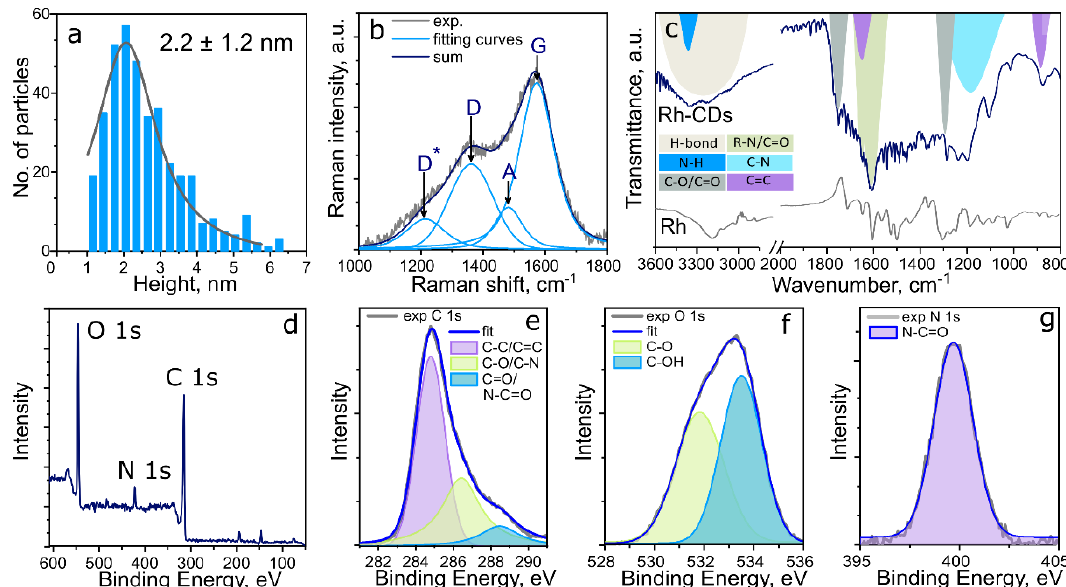
Figure 1. ( a ) Atomic force microscopy (AFM) height distribution of Rhodamine (Rh)-CDs. ( b ) Raman spectrum of Rh-CDs (exp., grey) and its deconvolution (sum, dark blue) into four peaks (fitting curves, light blue). ( c ) Fourier transform infrared (FTIR) spectra of Rh-CDs (dark blue) and Rh (grey); different types of molecular groups are shown by different color areas. ( d ) Full X-ray photoelectron spectroscopy (XPS) survey spectrum of Rh-CDs, and high-resolution XPS spectra of Rh-CDs: C1S ( e ), O1S ( f ), and N1S ( g ), with deconvolution of bands to specific peaks attributed to different chemical groups shown by different colors and explained in the legends.